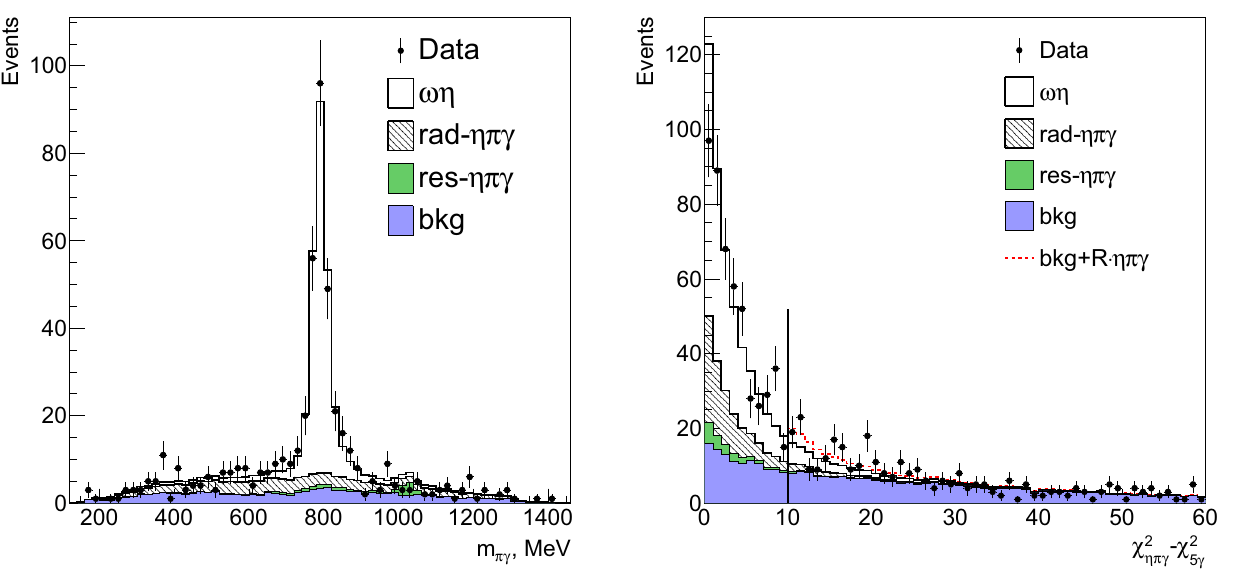
Fig. 1 Left panel: The π 0 γ invariant mass distribution for selected The histograms show cumulatively the simulated distributions for the < 10 (points four event classes. The distributions are normalized to the number of experimental events from the signal region χ 2 ηπγ − χ 2 5 γ events in the signal region. The dashed histogram shows the result of with error bars). The histograms represent the results of the fit described the fit after the correction of the signal distribution described in the text. inthetext.Thedistributionsforthefoureventclassesareshowncumula- The vertical line separates the signal and control tively.Rightpanel:The χ 2 ηπγ − χ 2 distributionforselectedexperimen- 5 γ tal events (points with error bars) from the signal and control regions.